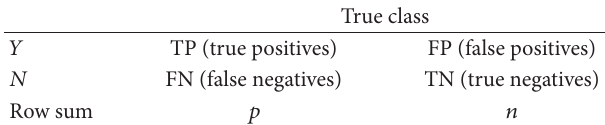
Table 1: Confusion